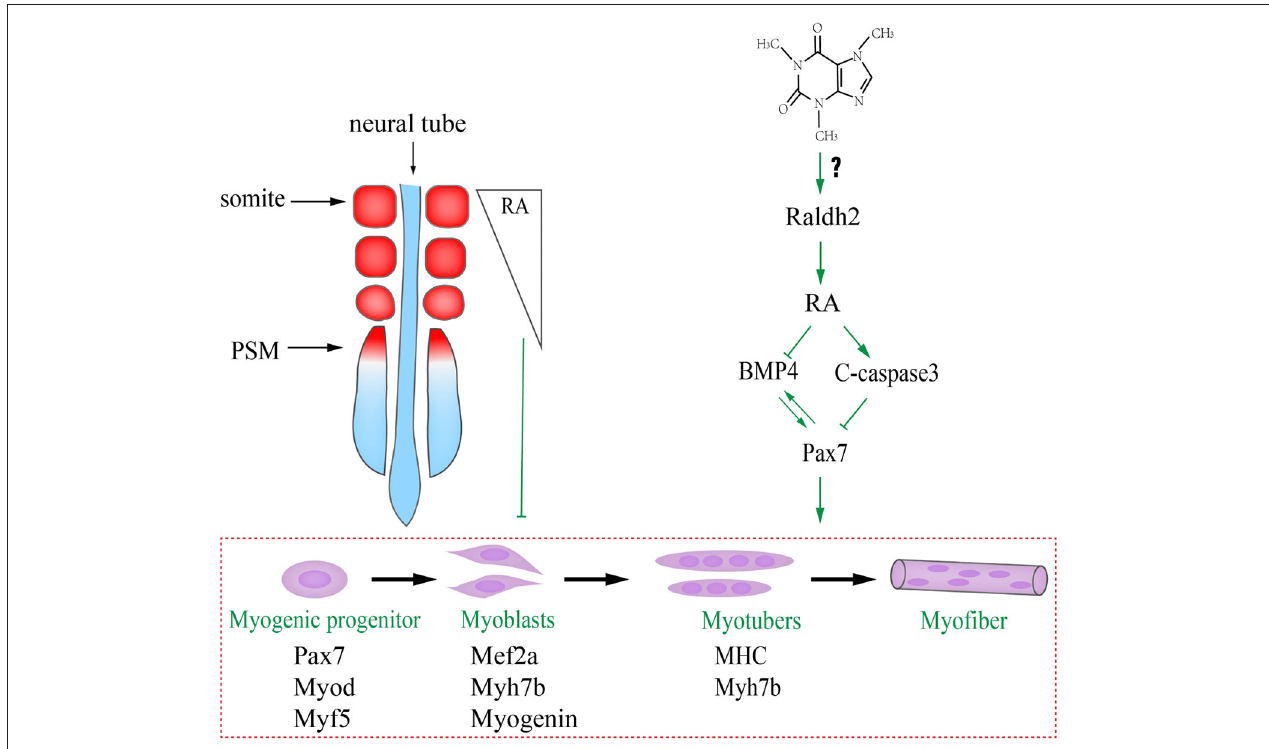
FIGURE 7 | Proposed mechanism about excessive caffeine intake-disturbed differentiation of myogenic progenitors through retinoic acid (RA) signaling